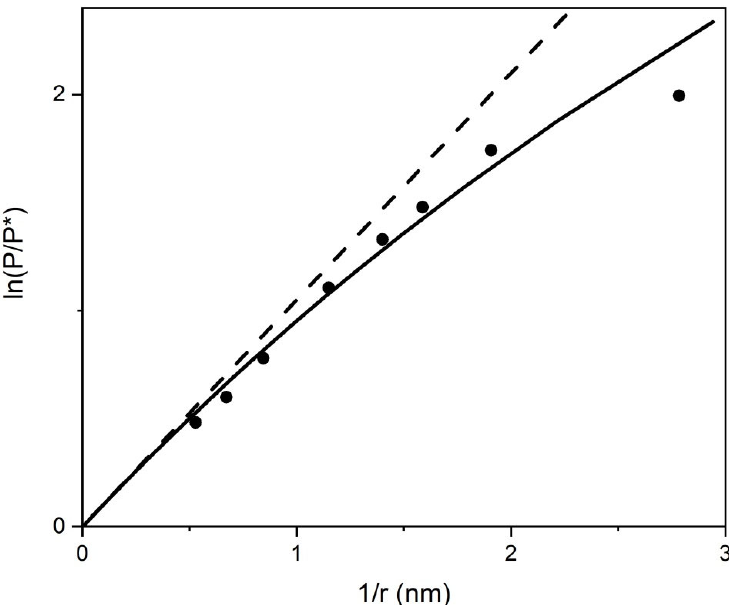
Figure 6. Logarithm of the relative vapor pressure of water nanodroplets ln ( P/P* ) as a function of the inverse radius r (nm) at temperature 298 K. The corresponding experimental values ( • ) from [30], compared to the values (- - - -) calculated with the Kelvin Equation (20) and ( — ) with the interaction function in Equation (19).